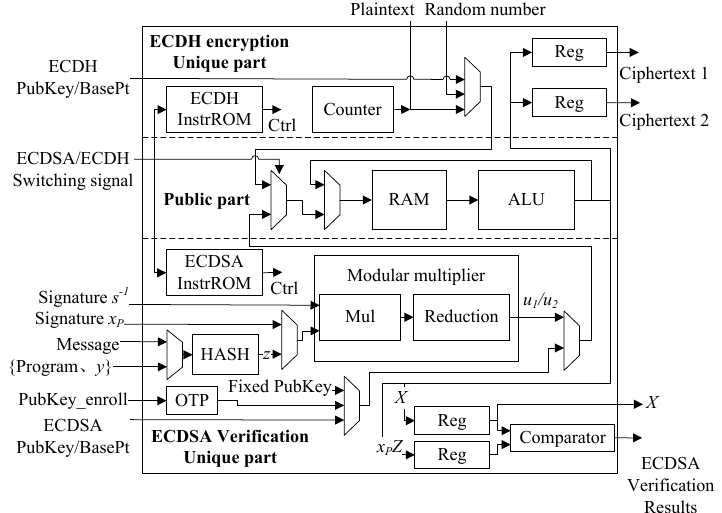
Figure 19. ECDH encryption module and ECDSA verification module